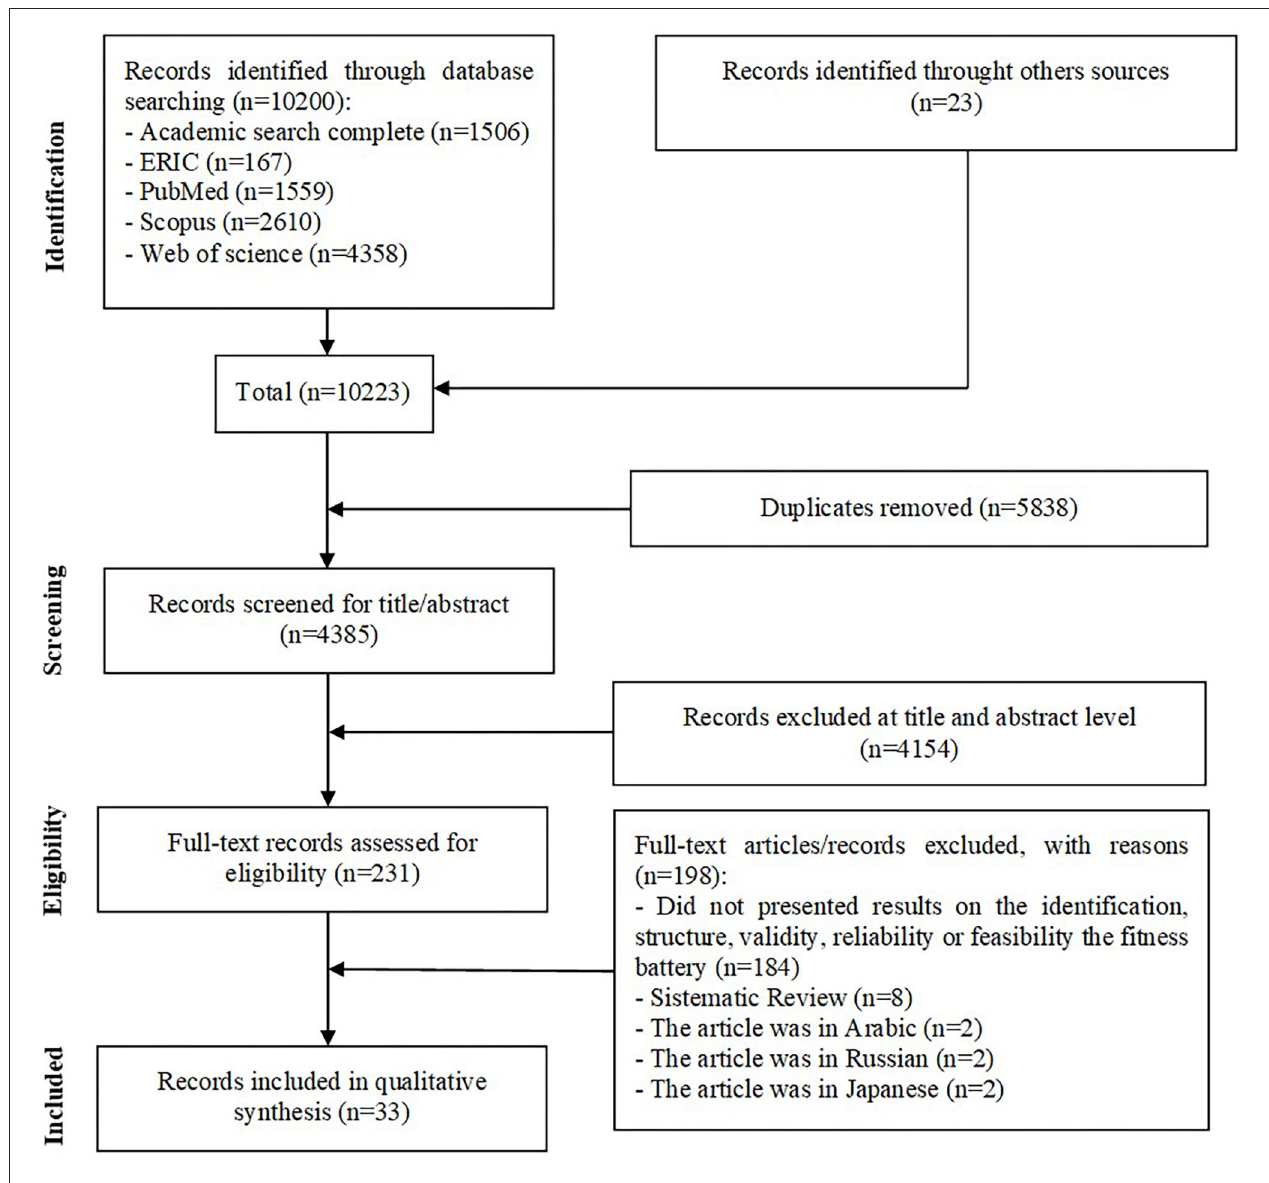
FIGURE 1 | Flow diagram of study